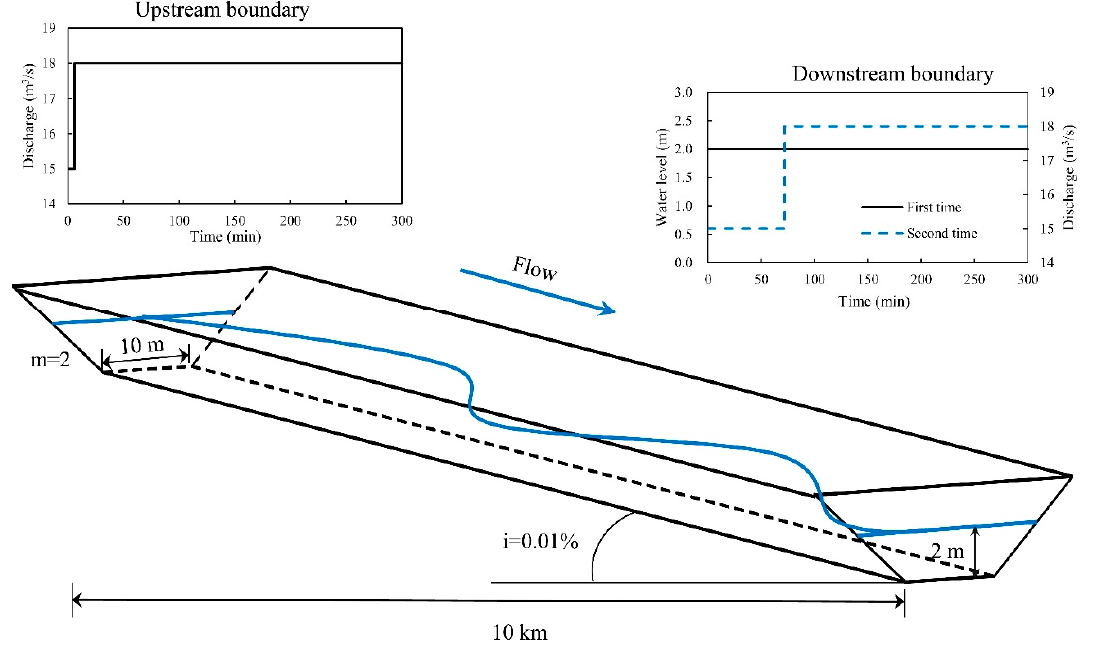
Figure 2. The experimental verification setup.